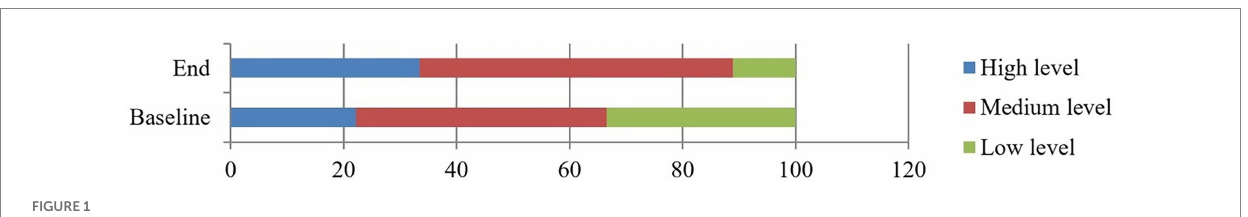
FIGURE 1 Dynamics of critical thinking level in the experimental